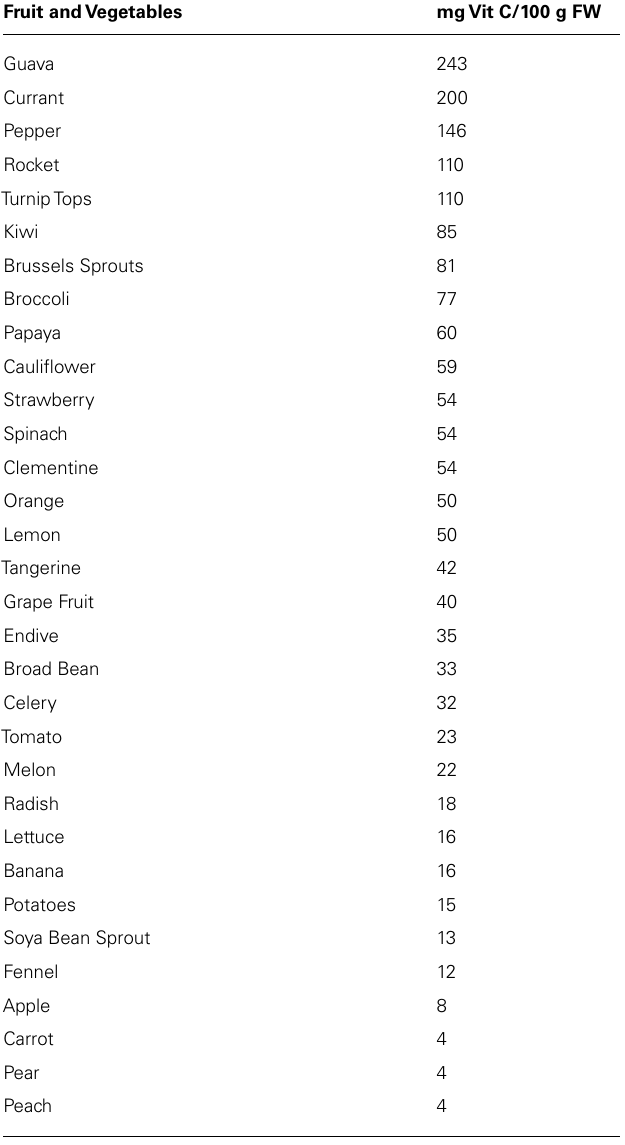
Table 1 |Vitamin C content in plant edible